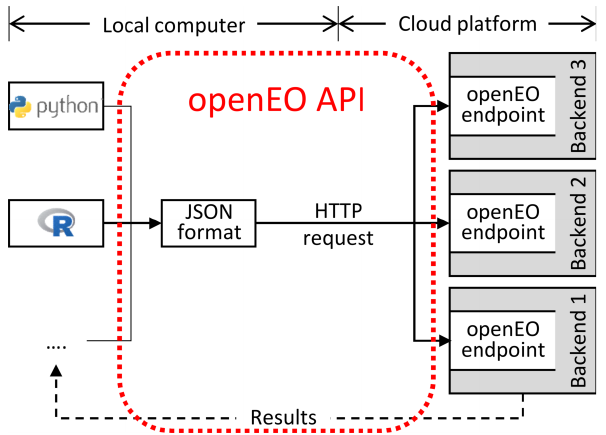
Figure 1. Communication between clients and backends. The openEO API specifies use of the JavaScript Object Notation (JSON) format and the way in which backends should respond to